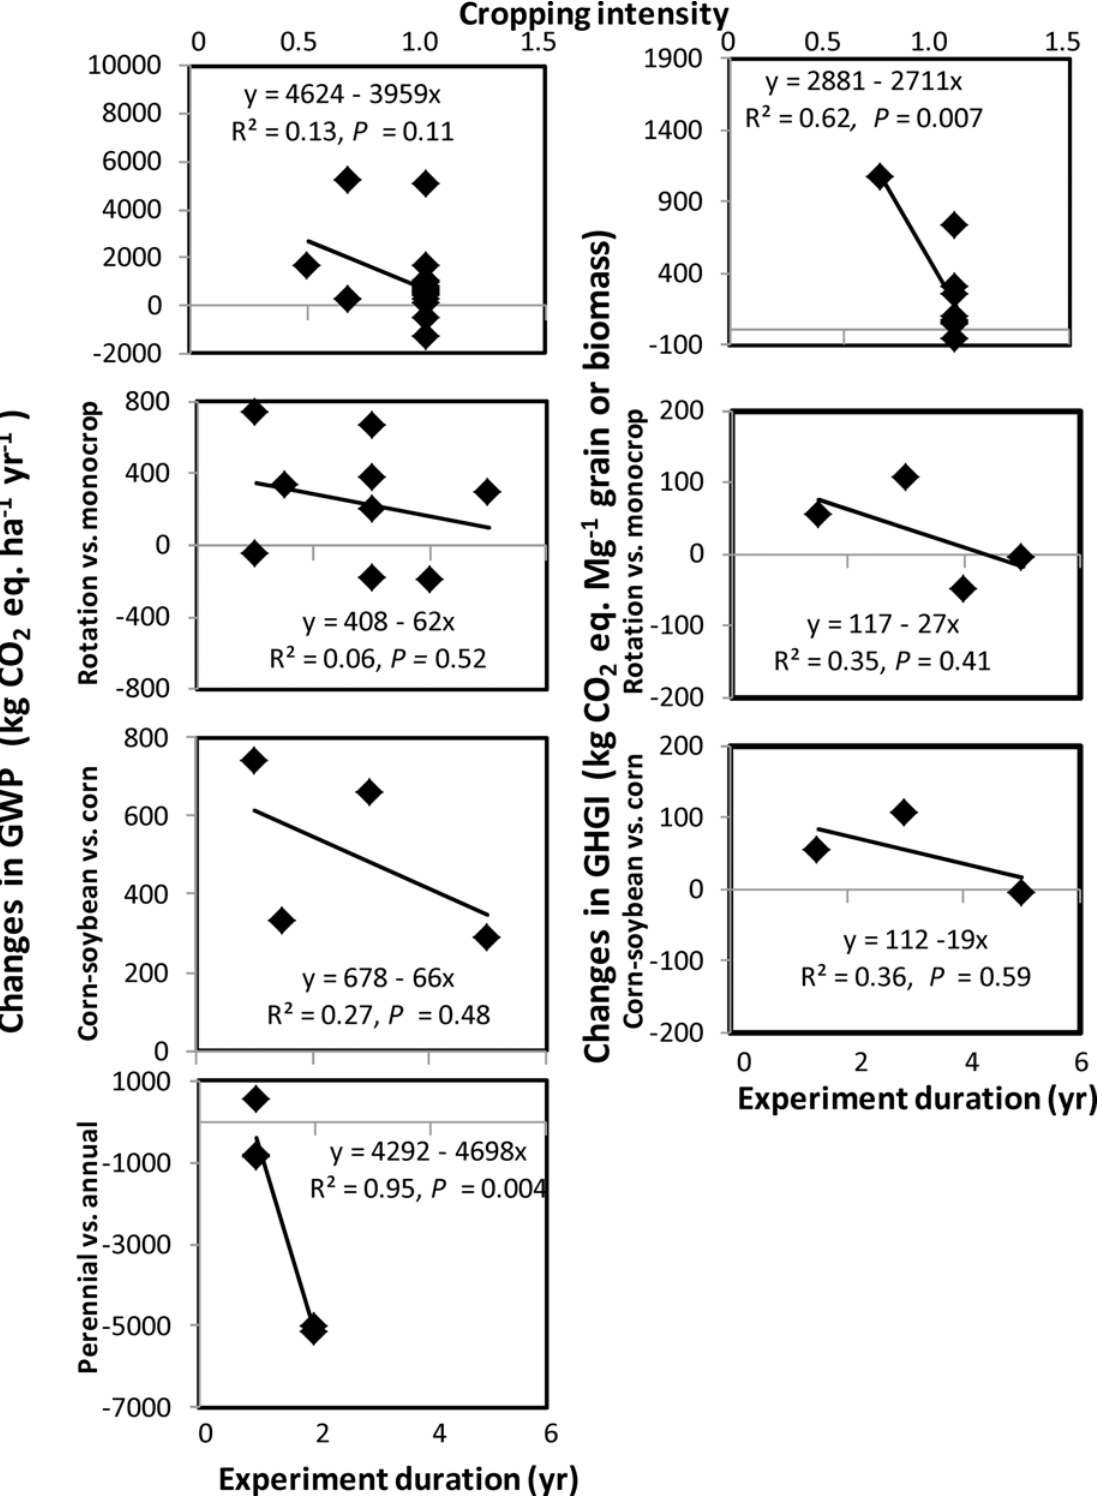
Fig 3. Changes in net global warming potential (GWP) and greenhouse gas intensity (GHGI) due to various cropping systems with the duration of the experiment using the soil organic C method. Because of the lack of sufficient data, only the all data option method of calculating GWP and GHGI were used for